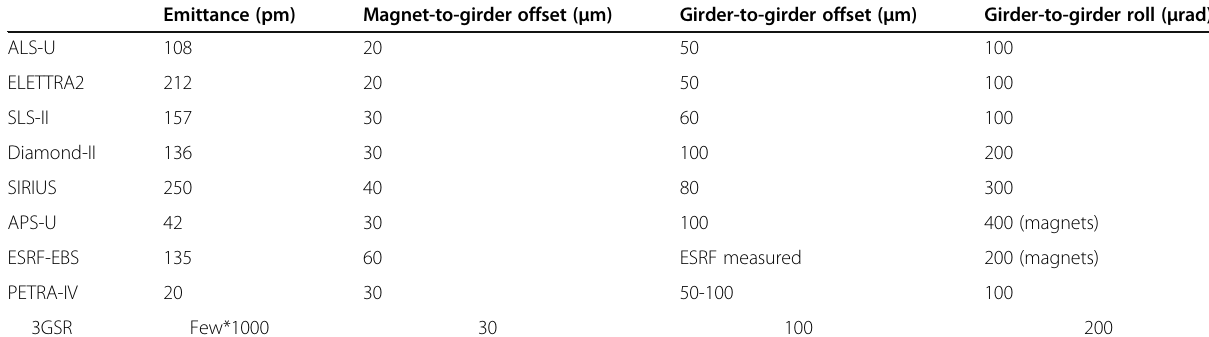
Table 3 Alignment tolerance for 4GSR [25]